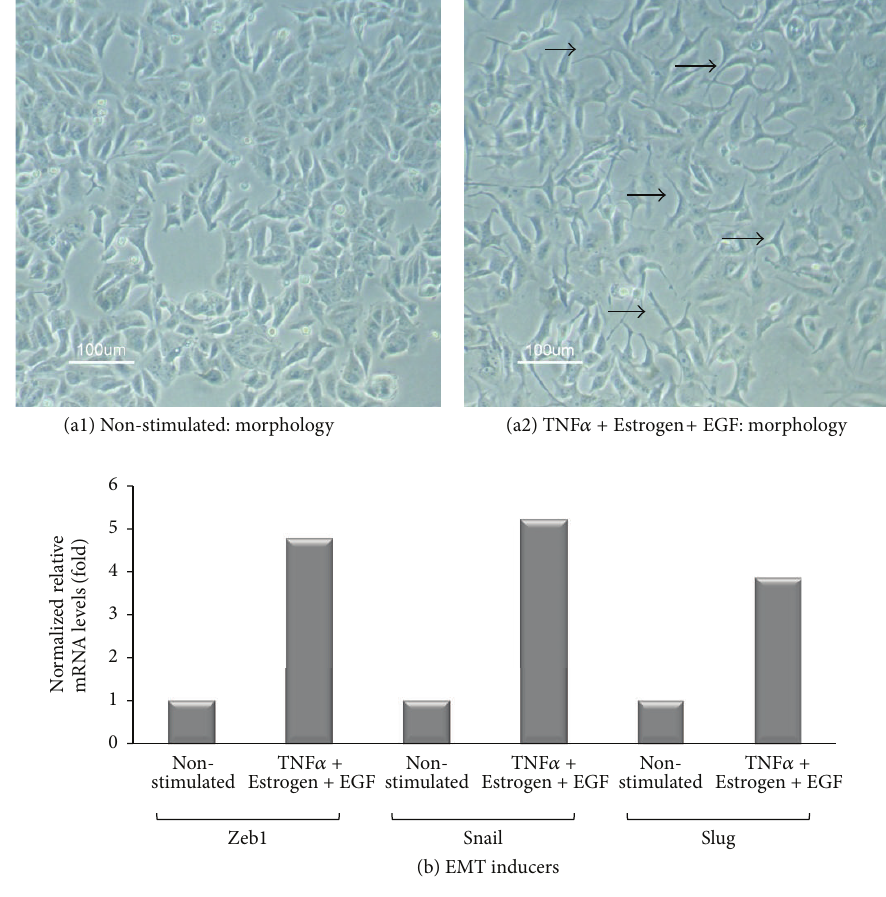
study indicate that tumor cells exposed to the